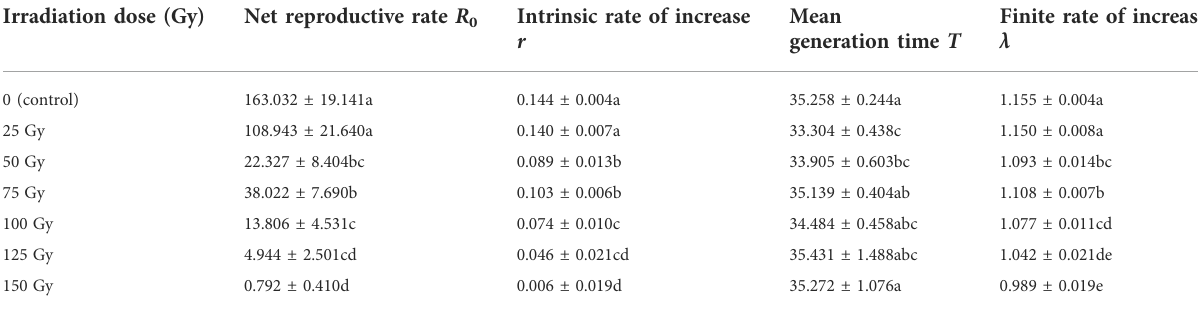
TABLE 5 Means (±SE) for life table parameters of Spodoptera litura F 1 generation after male parent was irradiated with different X-ray doses during pupal stage. Irradiation dose (Gy)